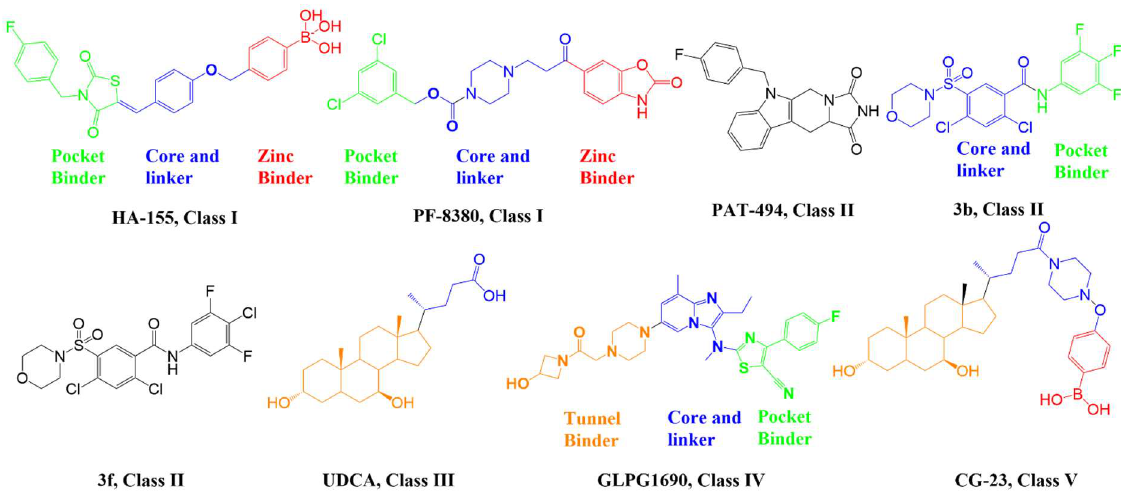
Figure 2. Classification of recently developed non-lipid small molecule ATX inhibitors. Core Linker Pocket binder Tunnel binder Zinc binder